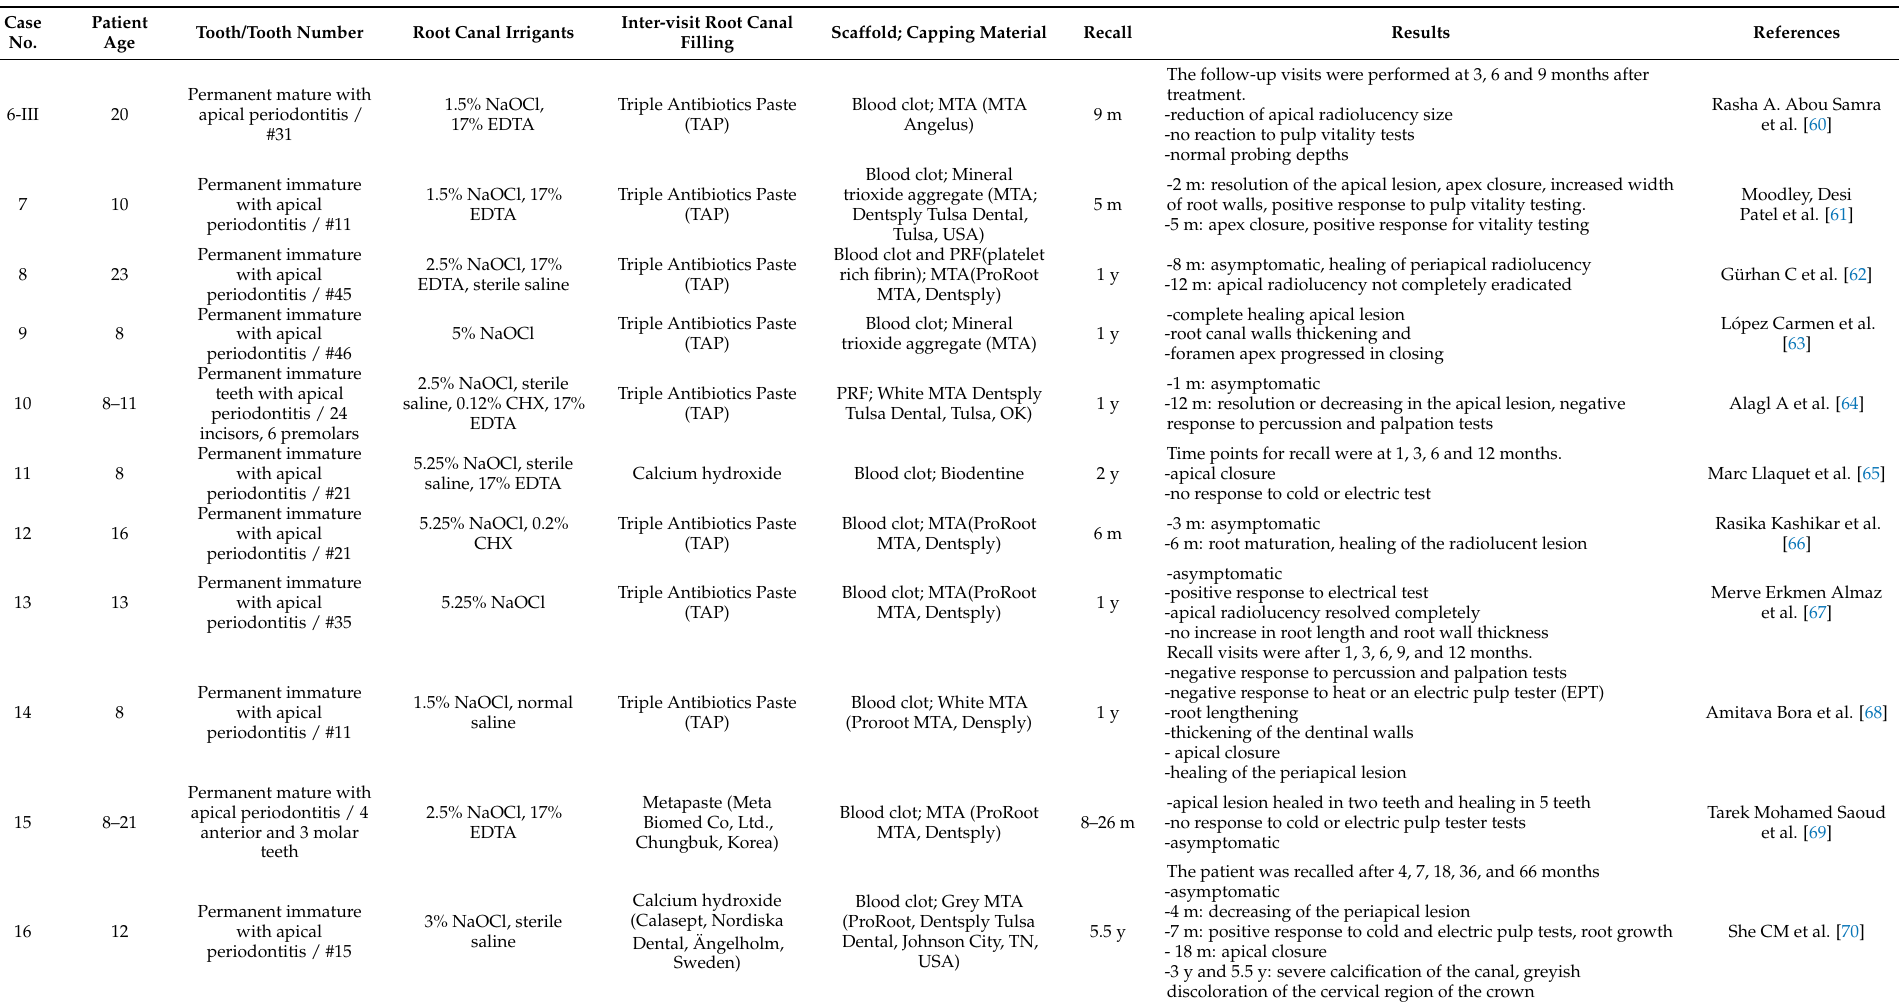
-1 m: asymptomatic -12 m: resolution or decreasing in the apical lesion, negative response to percussion and palpation tests